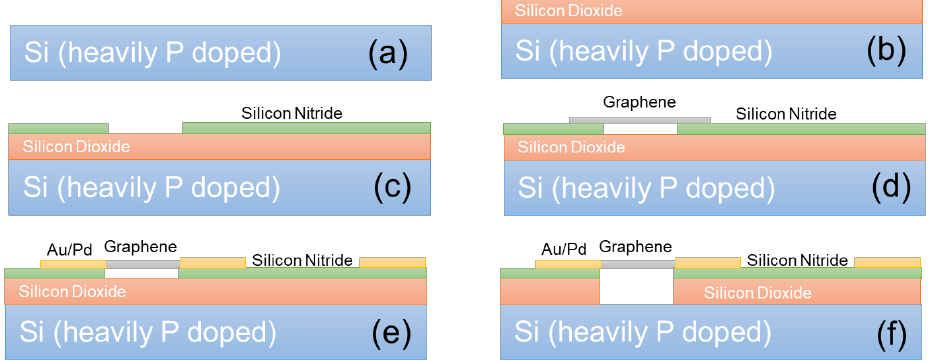
Figure 18. A CMOS-compatible process for fabricating gNEMS devices: ( a ) preparation of doped silicon, ( b ) thermal oxidation of silicon, ( c ) open a window in Si 3 N 4 , ( d ) transfer and pattern the graphene ribbon, ( e ) deposit the metal pad, and ( f ) HF etching SiO 2 to release the graphene membrane to form the gNEMS device.